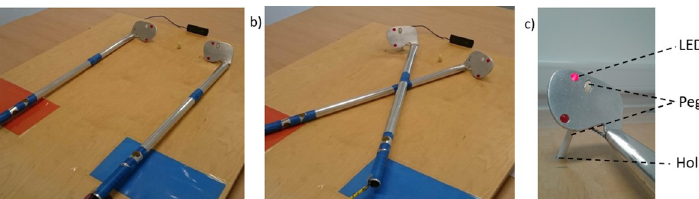
Fig 1. Tool-use materials. From left to right, the images depict the uncrossed (A), and crossed (B) tools, and a close- up of the end of a tool (C). The tools have red Light Emitting Diodes (LEDs) embedded at the far ends of the tools, and vibrotactile stimulators embedded in the handles. A vertical peg was attached to the far ends of the tools (white oval), which slotted into holes in the wooden board to ensure the position of the tips of the tools was consistent for crossed and uncrossed trials (C). An off-white LED fixation point was positioned with equal distance to the ends of both tools. A webcam was placed in line with the fixation light and the chinrest, which were aligned with participants’ sagittal